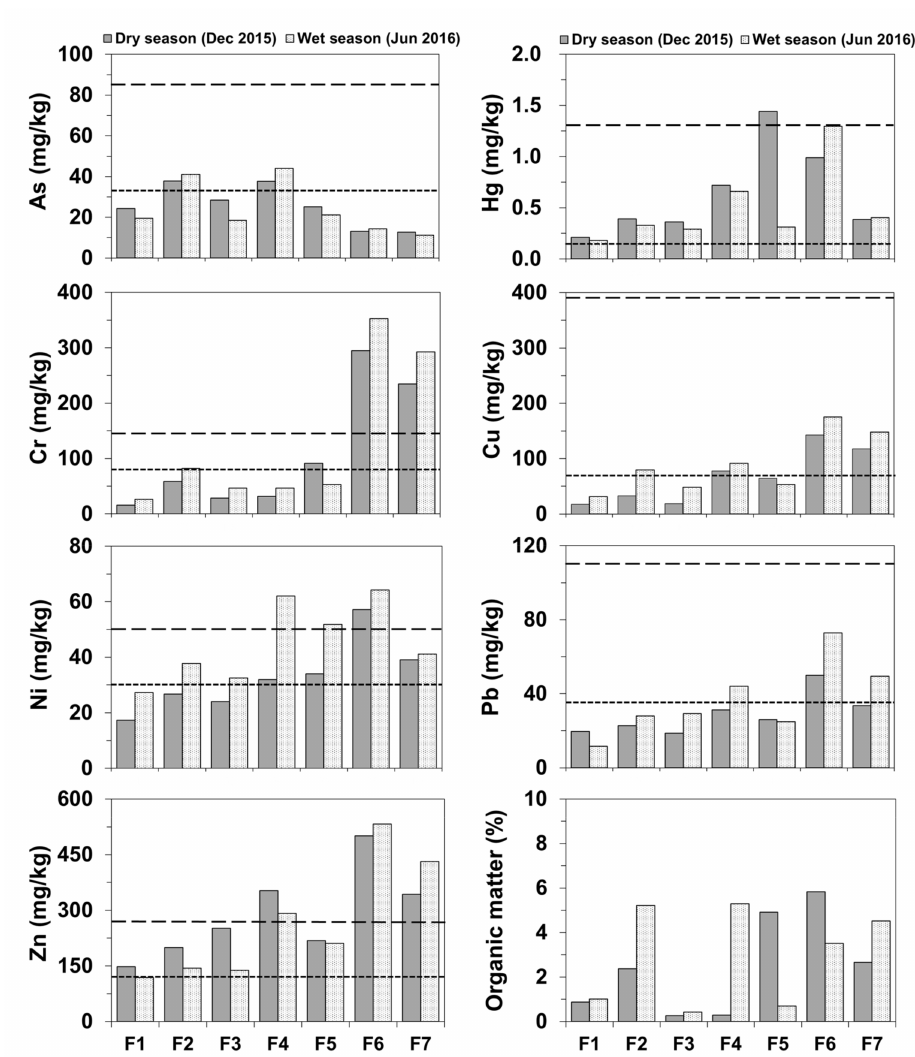
Figure 2. Spatial and seasonal variations in heavy metals (As, Hg, Cr, Cu, Ni, Pb, Zn) and organic matter contents in the sediments of Fengshan River. The horizontal dot lines and dash lines represent the ERL and ERM values,